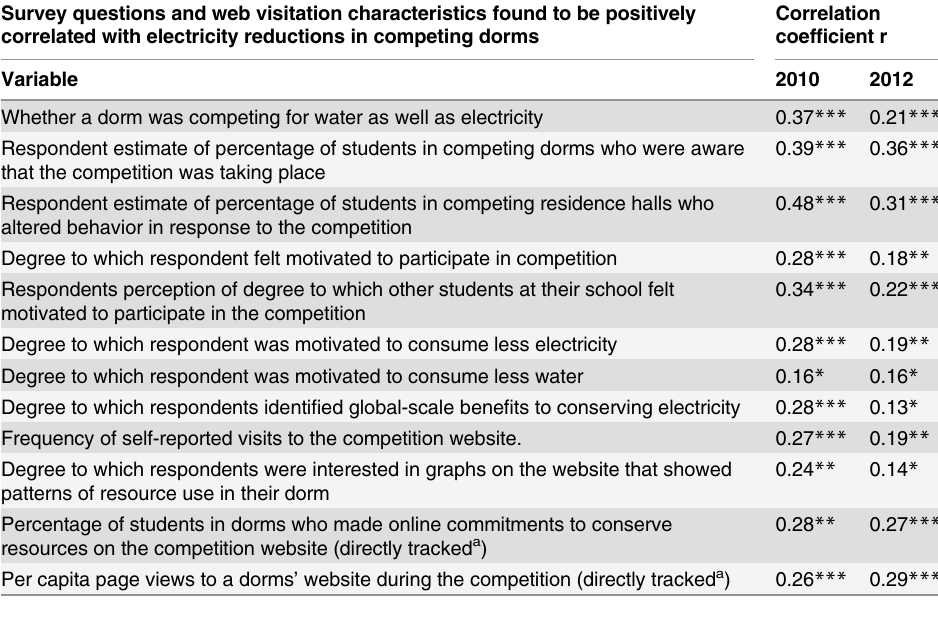
Table 8. Factors that were significantly correlated with percent reductions in electricity use in response to the competition in both years. The number of asterisks adjacent to the correlation coefficient (r) indicates significant level: p < 0.001 = *** , p < 0.01 = ** , p < 0.05 = * . All significant relationships reported below are